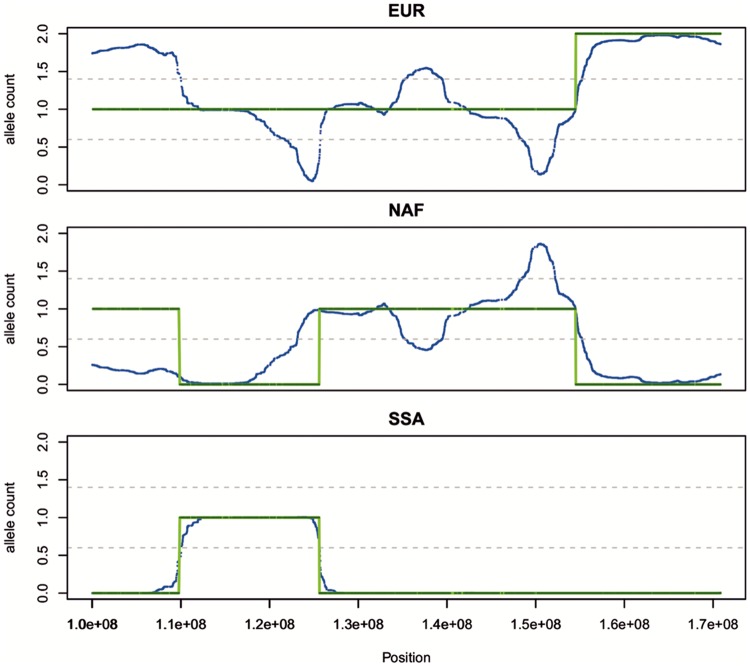
Inference of local ancestry by ELAI and LAMP-LD. The plot shows an example of inference in a chromosome region (one panel of each parental population) comparing ELAI (blue) with LAMP-LD (green) allele dosages.